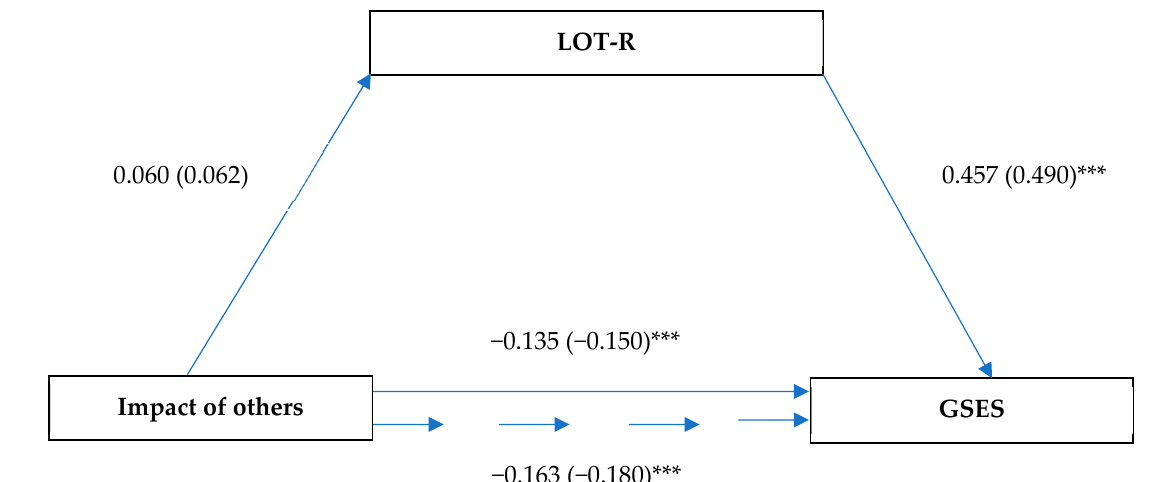
direct impact of dispositional optimism on self-efficacy was also significant ( β = 0.49; SE = 0.05; p < 0.001). With the mediator included, the association between random events and Figure 4. Model of relationships between health locus of control (impact of others), dispositional Figure 4. Model of relationships between health locus of control (impact of others), dispositional self-efficacy became positive, with a value of 0.07 (SE = 0.04, p = 0.044; LLCI = 0.020; ULCI optimism, and self-efficacy. Unstandardized coefficient (standardized coefficient); *** p < 0.001. optimism, and self-efficacy. Unstandardized coefficient (standardized coefficient); *** p < 0.001. = 0.147).